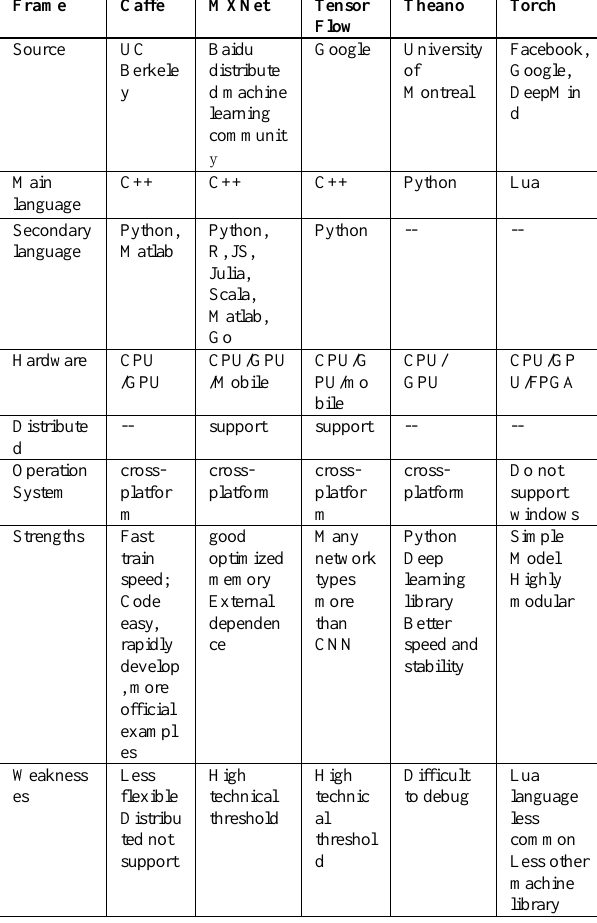
Table 1. Current mainstream deep learning